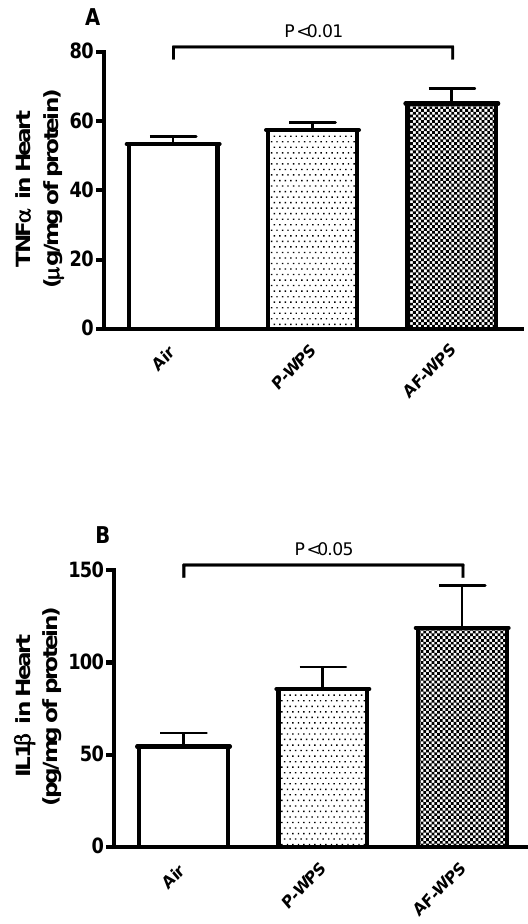
Figure 7. Effects of plain water-pipe smoke (P-WPS) or apple-flavoured (AF)-WPS on markers of inflammation. Heart homogenate concentrations of tumour necrosis factor α (TNFα, A ) and interleukin 1β (IL-1β, B ) at the end of 1 mo exposure period to either air or P-WPS or AF-WPS. Data are mean ± SEM (n = 6–8); one-way ANOVA followed by Holm–Sidak’s multiple comparison test.